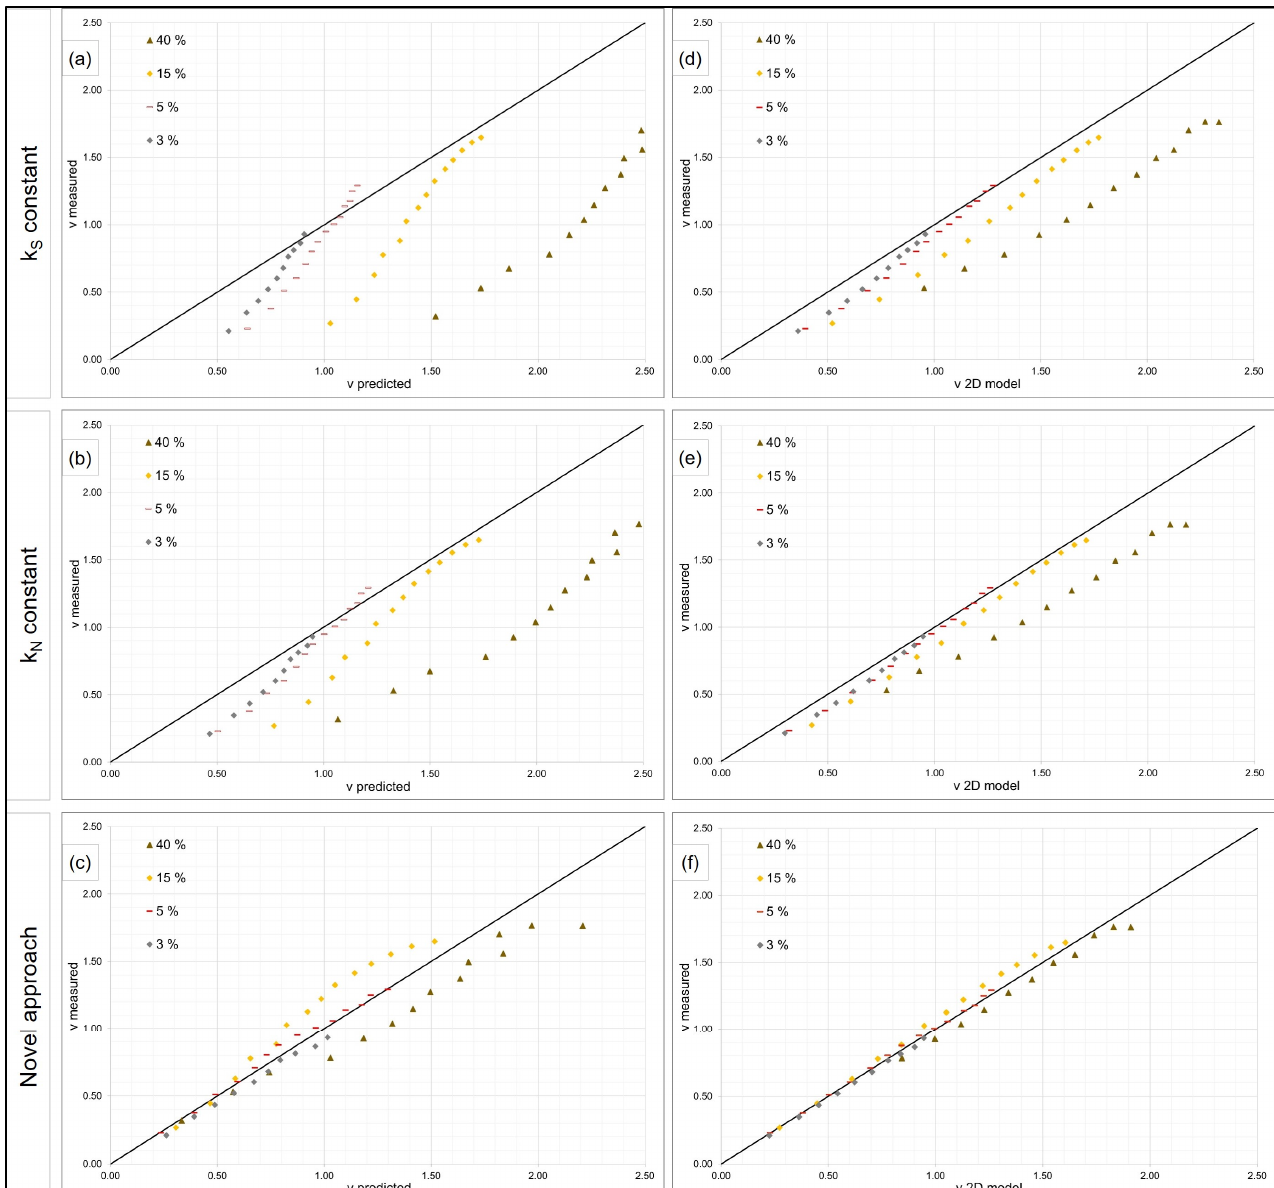
Figure 7. Comparison of approaches k S = constant, k N = constant and novel approach, manually calculated and implemented in 2D model. ( a – c ): Comparison of predicted velocity and measured velocity for 3%, 5%, 15% and 40%. ( d – f ): Comparison of velocity from the 2D model and measured velocity for 3%, 5%, 15% and 40%.